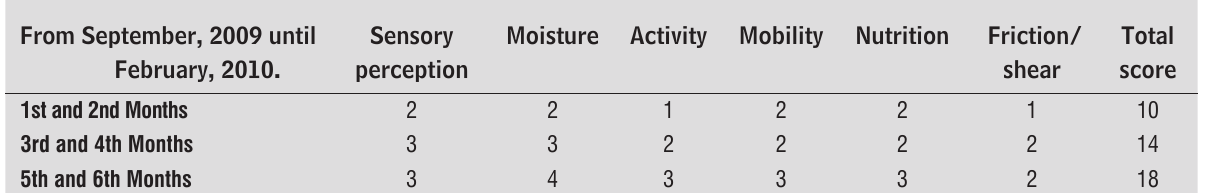
Table 2 - Scores obtained during the six months of